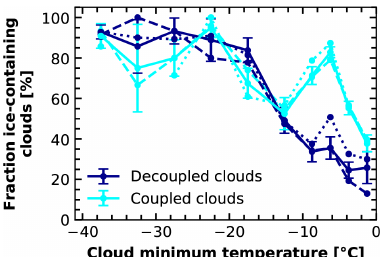
Figure B2. Continuous lines same as Fig. 4. The dashed lines rep- resent the respective results for the upper end of the error margin (i.e., profiles were classified as decoupled using a threshold for the coupling state of 0.5 plus the error in θ ), and the dotted lines repre- sent the lower end of the error margin (i.e., profiles were classified as decoupled using a threshold for the coupling state of 0.5K minus the error in θ